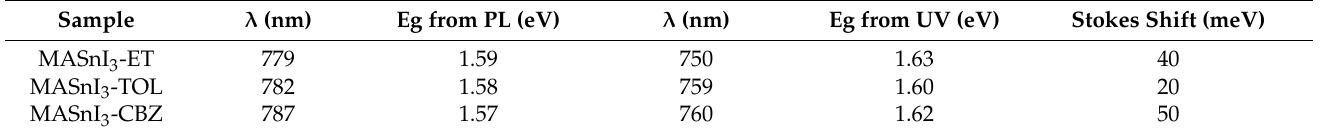
Figure 3. ( a ) Absorption of MASnI 3 films, ( b ) bandgap, and ( c ) PL spectra after treatment with toluene, diethyl ether, and chlorobenzene, ( d ) structure of MASnI 3 . Table 2. Optical bandgaps of the MASnI 3 samples treated with toluene, diethyl ether, and